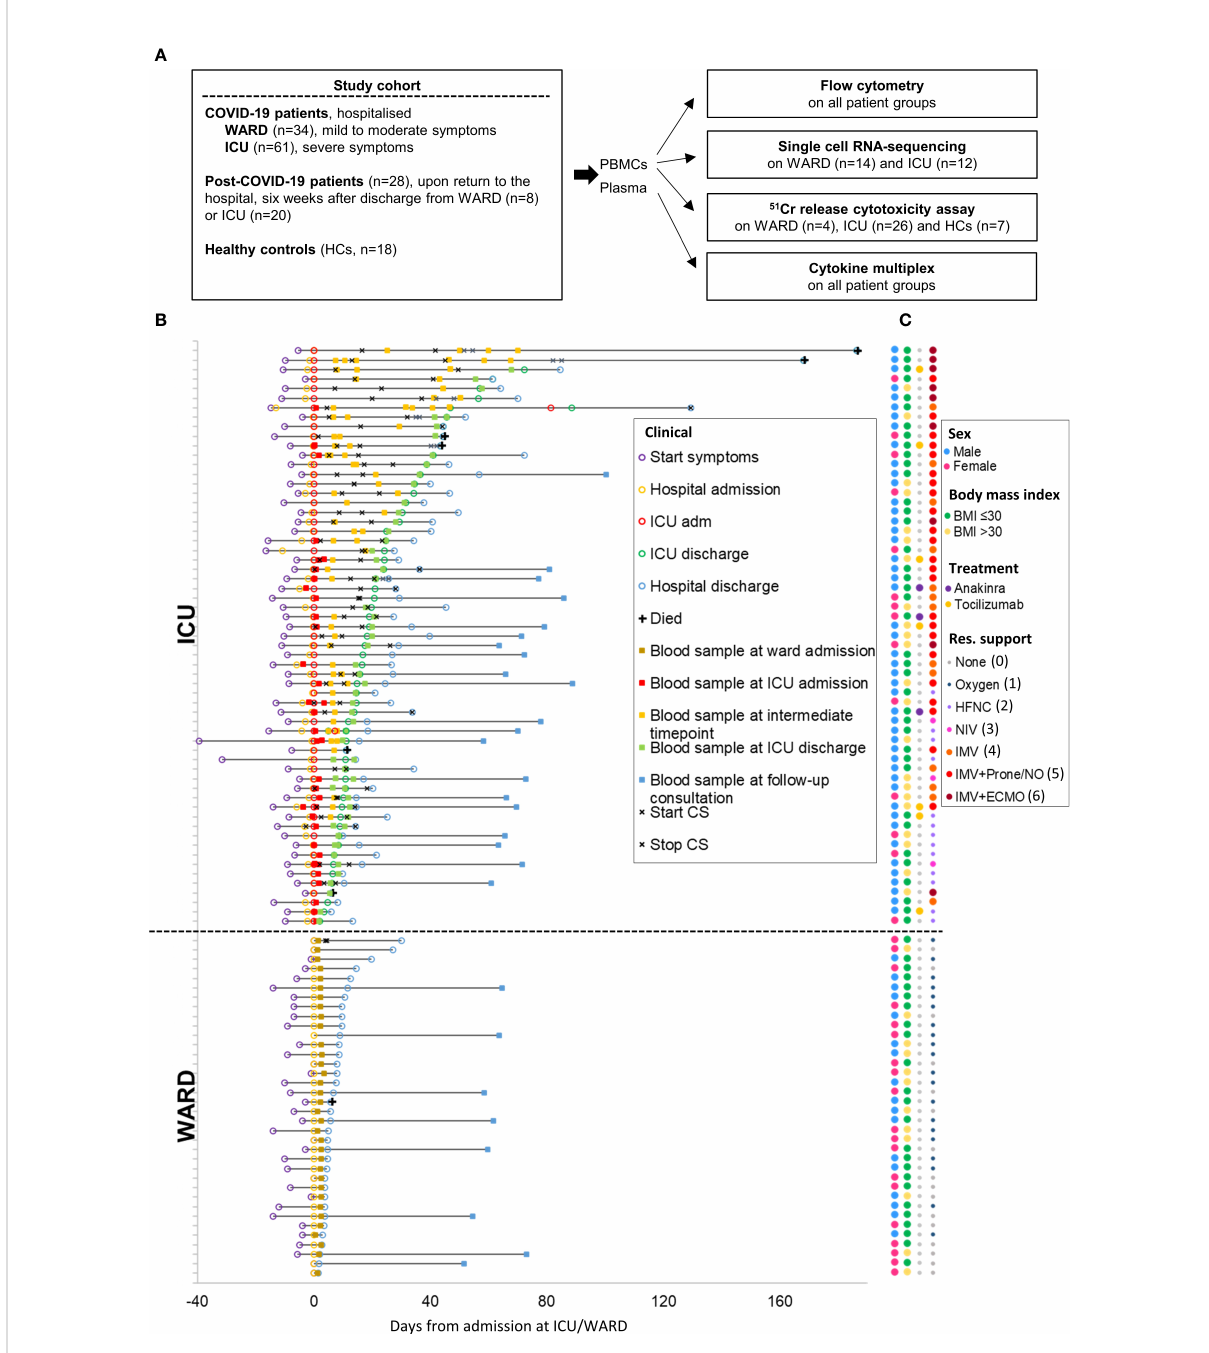
FIGURE 1 Study design and COVID-19 patient cohort. (A) Schematic overview of study design and the number of included patients. (B) Detailed timeline highlighting all clinical milestones according to their relative time (days) from each patient ’ s admission to ICU or WARD. Additionally, start and stop of corticosteroid (CS) treatment was shown. (C) Dot plot indicating the gender, body mass index (BMI), additional treatment, and maximal respiratory support. The respiratory support levels were classi fi ed from 0 to 6 [level 0 indicates no support, level 6 invasive mechanical ventilation (IMV) with extracorporeal membrane oxygenation (ECMO)]. Oxygen (level 1); HFNC, high fl ow nasal cannula (level 2); NIV, non- invasive ventilation (level 3); IMV (level 4) IMV + prone/NO, nitric oxide (level